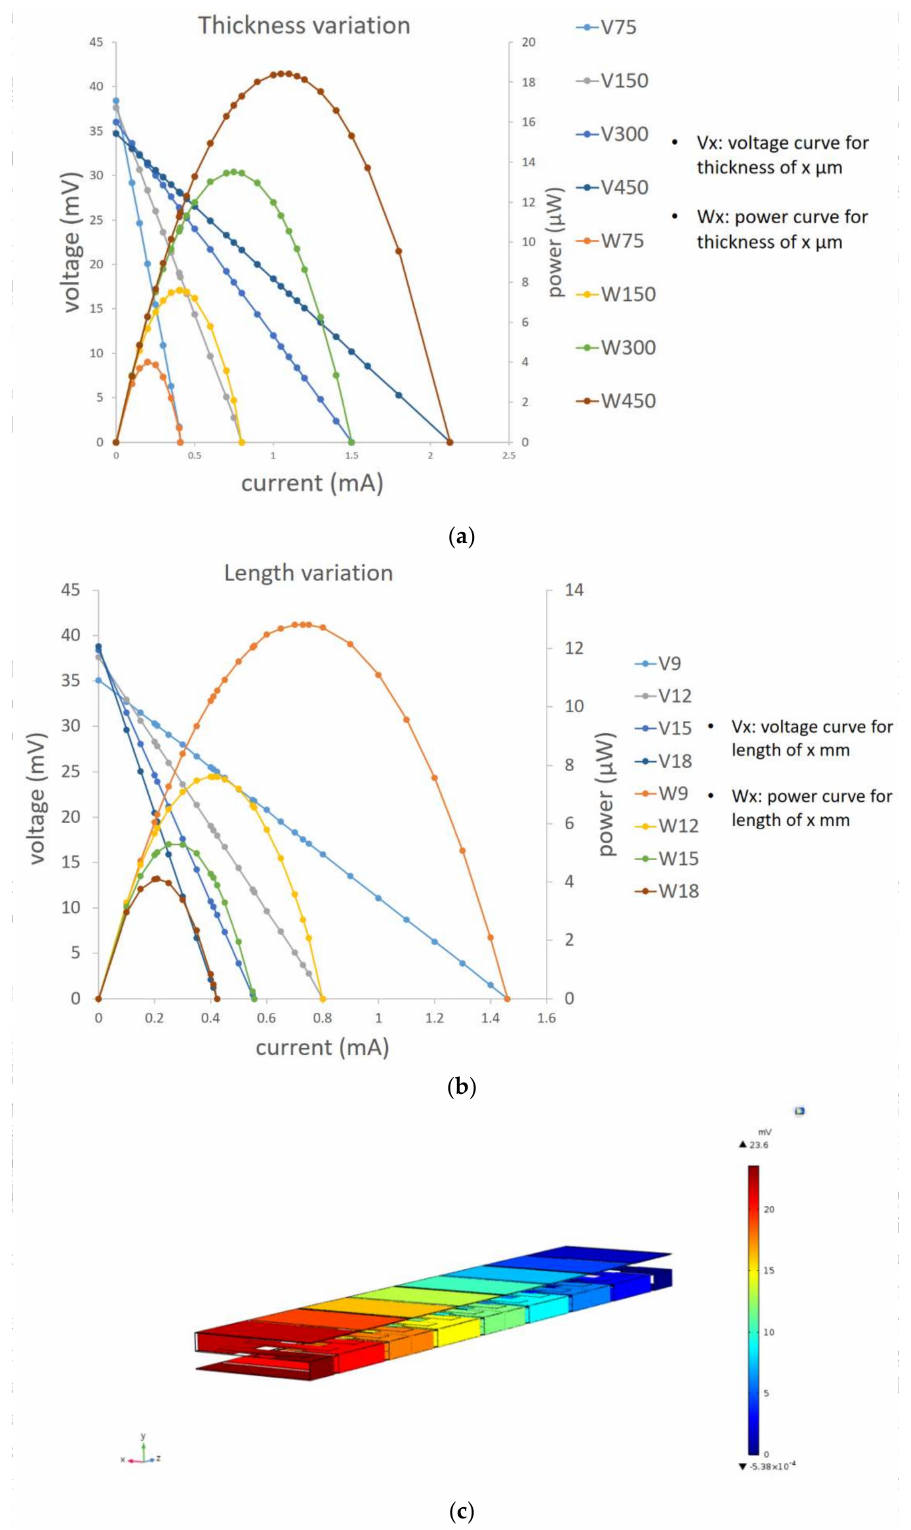
Figure 7. ( a , b ) Leg thickness and length variation; ( c ) electrical potential